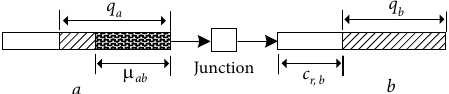
Figure 3. The case of downstream link is nearly